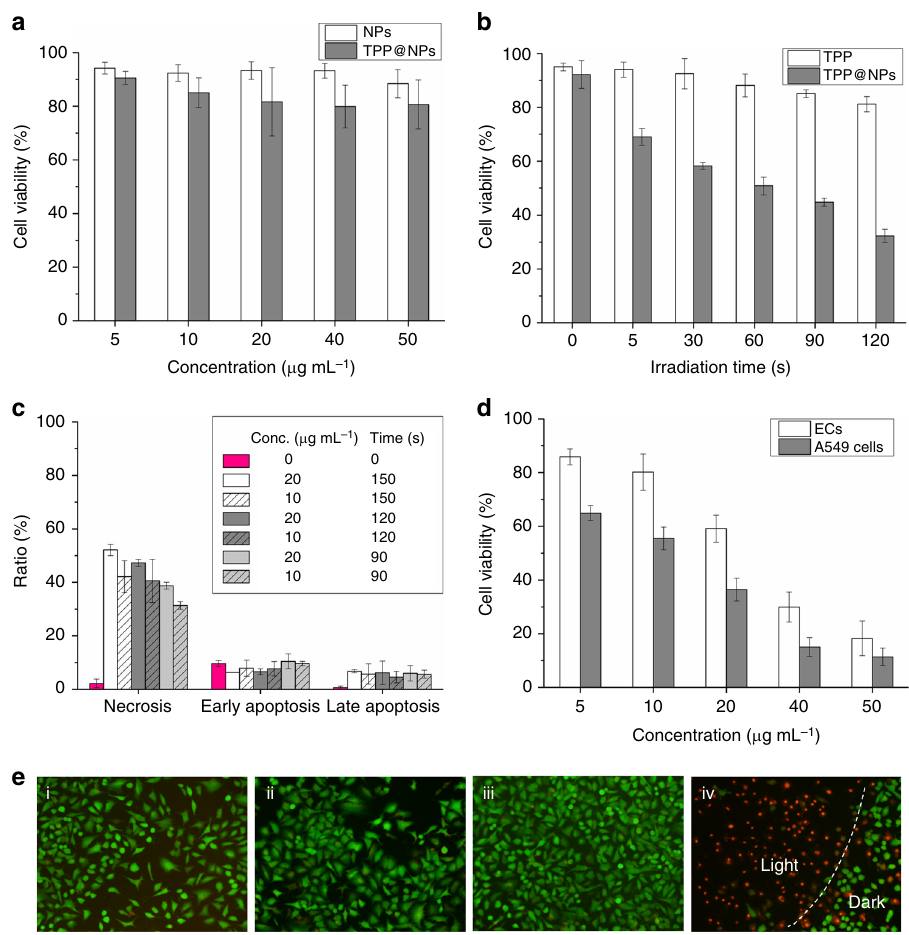
Fig. 5 In vitro PDT. a Dark cytotoxicity of NPs and TPP@NPs to A549 cells. b Irradiation time-dependent light cytotoxicity of TPP and TPP@NPs to A549 cells. The concentration of TPP@NPs was 20.0 μ g mL ‒ 1 . c Cell apoptosis analysis by fl ow cytometry of A549 cells treated with 20.0 μ g mL ‒ 1 of TPP@NPs and 120 s of irradiation. The cells were incubated for another 12 h after PDT. d Concentration-dependent light cytotoxicity of TPP@NPs to ECs and A549 cells to show target ability. The irradiation time was 120 s. e Living and dead cell imaging of A549 cells: (i) control, (ii) irradiation, (iii) TPP@NPs and (iv) TPP@NPs with irradiation. The boarder of laser was marked with white dash line in (iv) and the cells in the left side of the boarder were exposed to laser. The cell death occurred in the right side was ascribed to the fl aw of laser collimation. Data are expressed as means ± s.d. ( n =